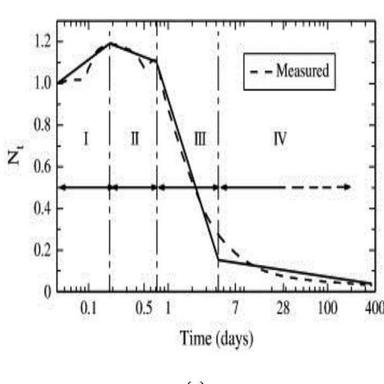
Temporal changes in conductivity (a) and normalized conductivity (b) values. (at 75 mm) over test period for concrete mixes and (c) schematic diagram of the four stages shown in (a) and (b).